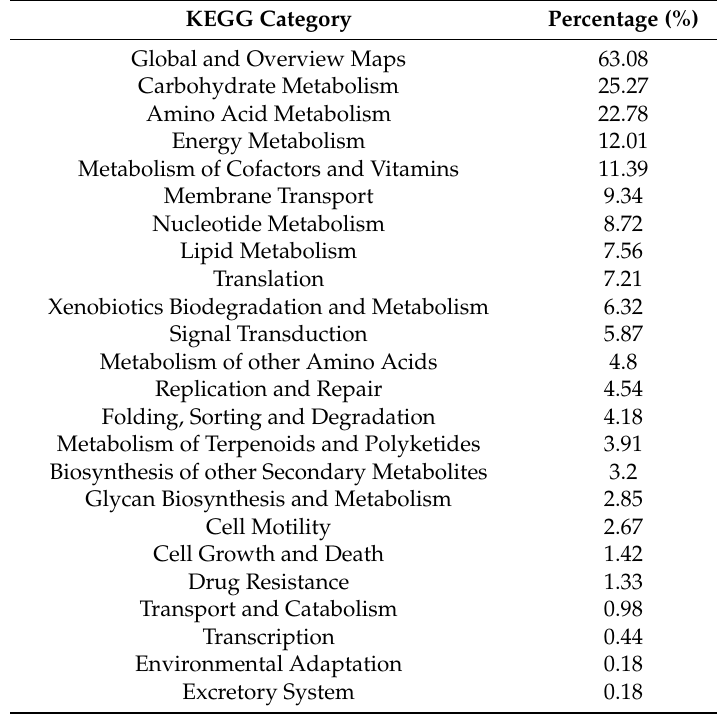
Table 1. Functional traits connected with Kyoto Encyclopedia of Genes and Genomes (KEGG) pathways identified from the whole genome sequence of Arthrobacter sp. strain SRS-W-1-2016. This figure